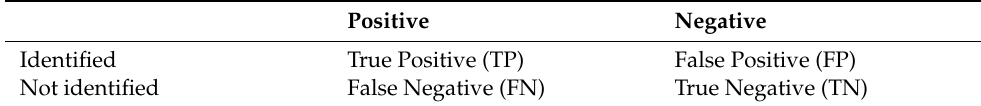
Table 1. Meaning of TP, FP, FN, and